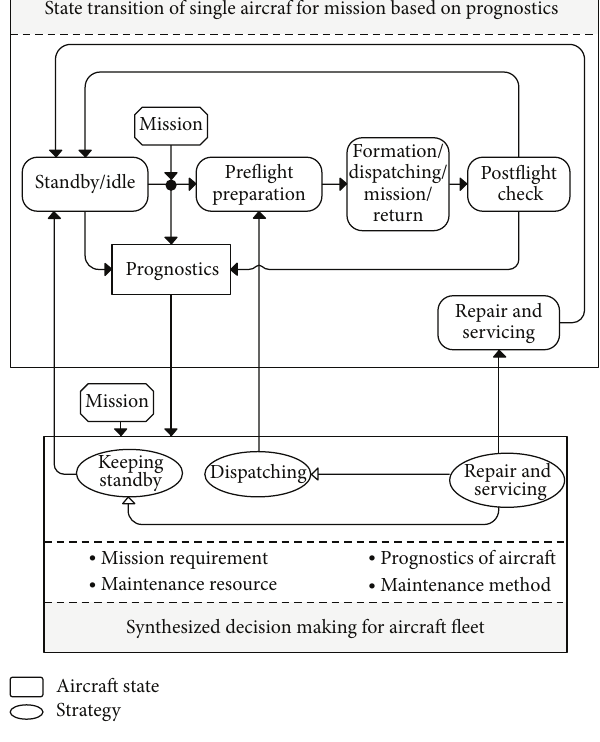
Figure 1: CBM for aircraft